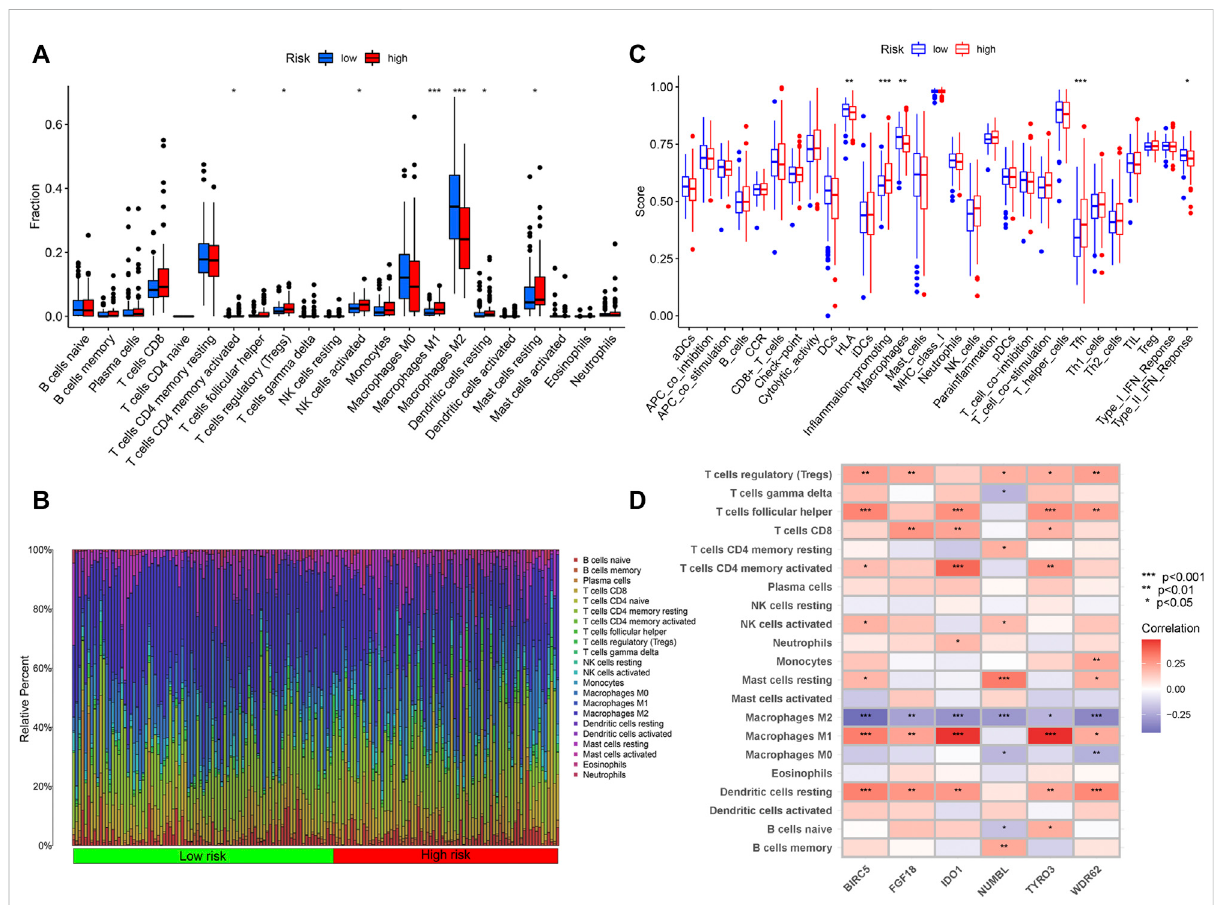
FIGURE 6 Immune Characteristics of different IRGPI subgroups. (A) Correlations of IRGPI with immune cell in fi ltration. (B) In fi ltration pro fi les in the high and low risk groups. (C) Correlations of IRGPI with immune function. IRGPI: immune-related gene prognostic index. (D) Heatmap of the correlation of the levels of in fi ltration of the immune cells with 6 risk genes. *** p < 0.001, ** p < 0.01, * p <